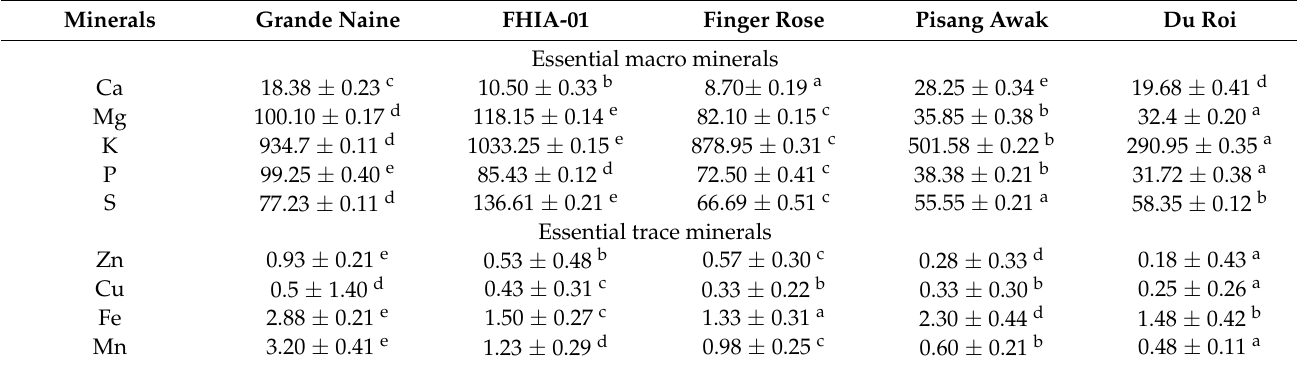
Table 2. Essential minerals in green banana flour from different cultivars (mg/100 g dry weight). Minerals Grande Naine FHIA-01 Finger Rose Pisang Awak Du Roi Essential macro